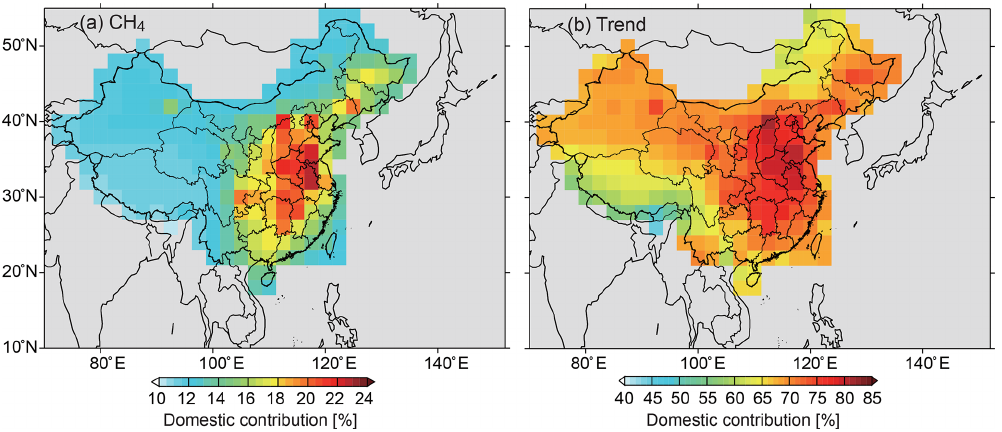
Figure 12. Spatial distributions of Chinese domestic emission contributions in percentage for CH 4 surface mixing ratios (a) and trends (b) in 2007–2018 over China. The percentage contributions are estimated by summing up all the Chinese-tagged CH 4 tracers divided by the total CH 4 tracers in the tagged